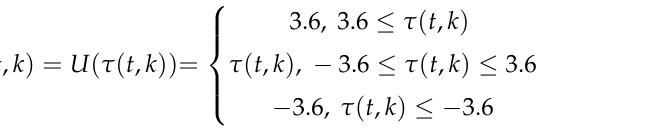
Figure 3. The randomly varying factor m ( k ) in y